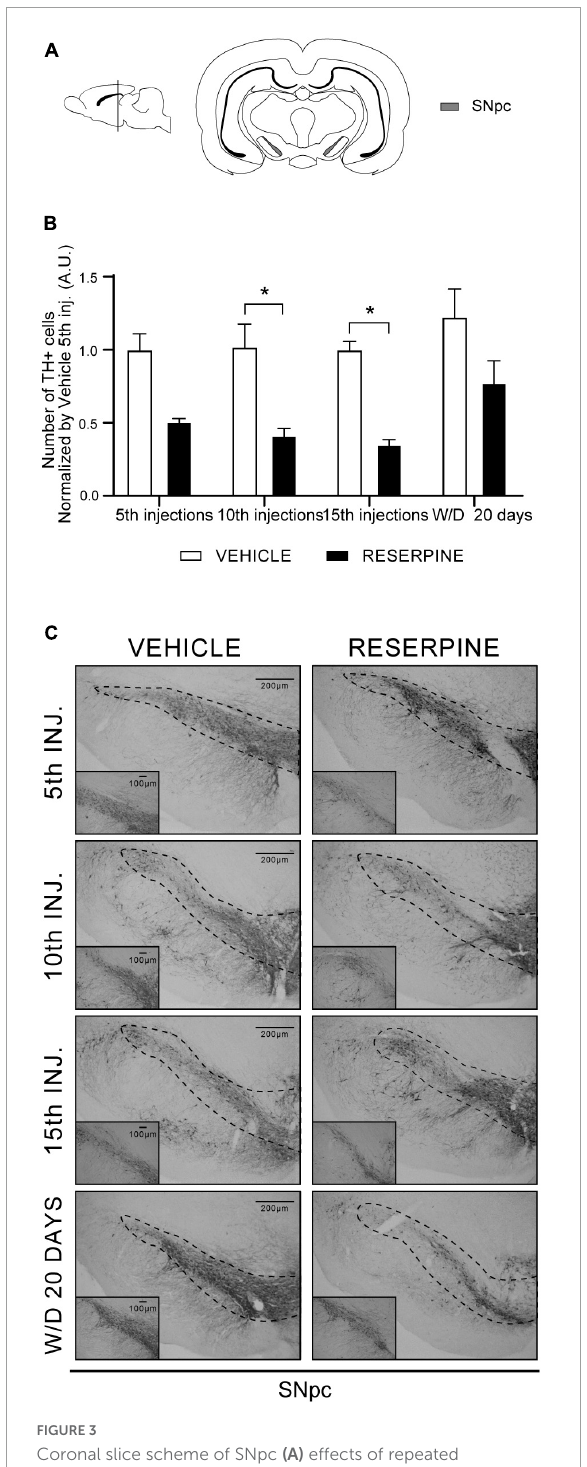
FIGURE3 Coronal slice scheme of SNpc (A) effects of repeated administration of 0.1 mg/kg reserpine ( n = 5) on number of TH + cells in the SNpc (B) and representative photomicrographs of TH immunostaining in SNpc coronal sections (C) . Data are shown as mean + SEM., * p < 0.05 comparing Reserpine and Vehicle groups (ANOVA followed by Sidak’s test). Scale bar in SNpc: 200 µ m and magnification 4x in overview images and scale bar of 100 µ m further magnified insets